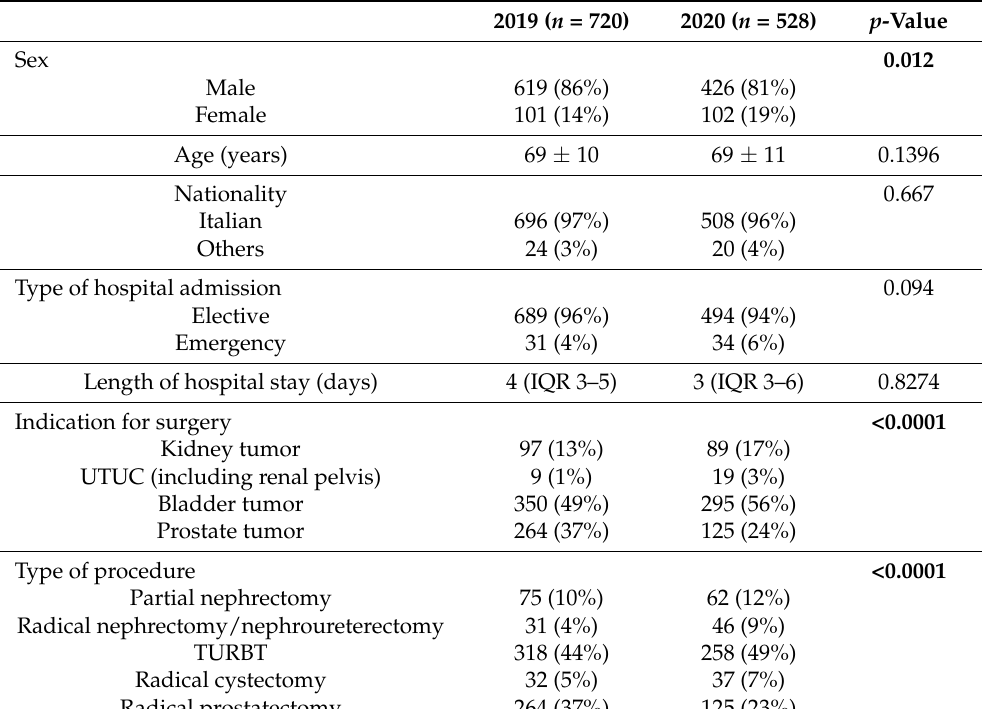
Table 1. Characteristics of patients undergoing urologic oncology surgeries in 2019 and